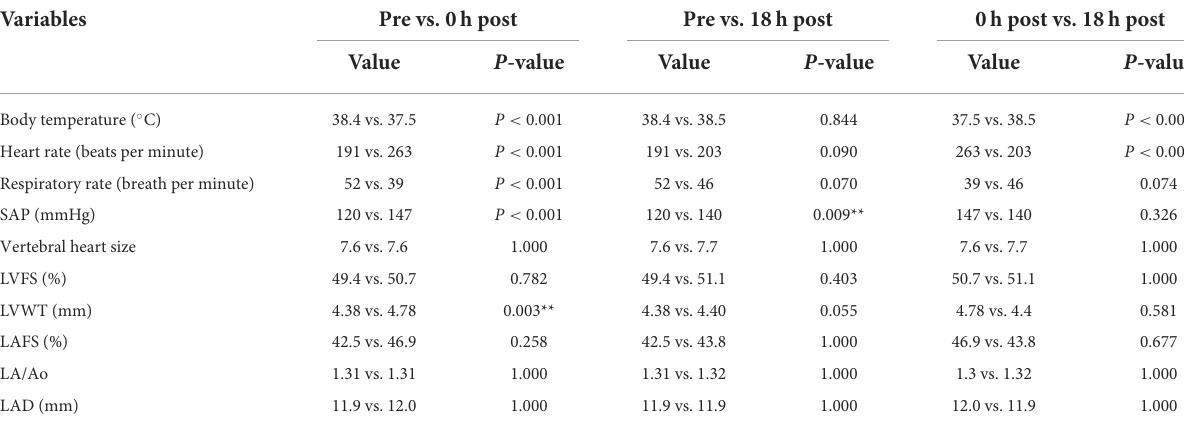
TABLE 2 Echocardiographic measurements and clinical data of all cats at pre-operation, 0h post-operation, and 18h post-operation.